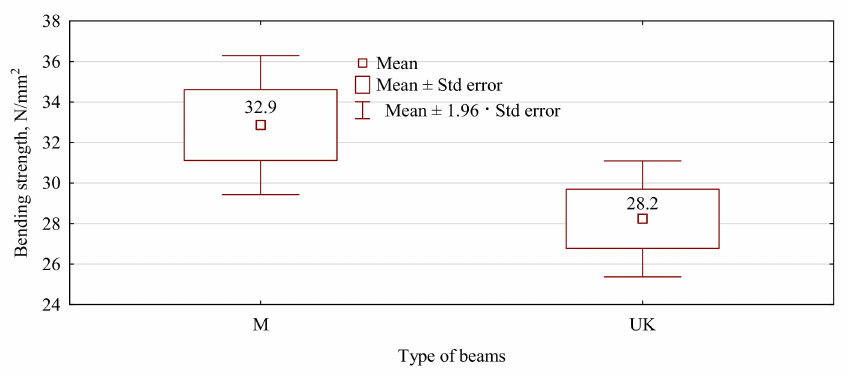
Figure 3. Static bending strength in a 4-point test for manufactured beams. Table 2. Statistical analysis of bending strength.